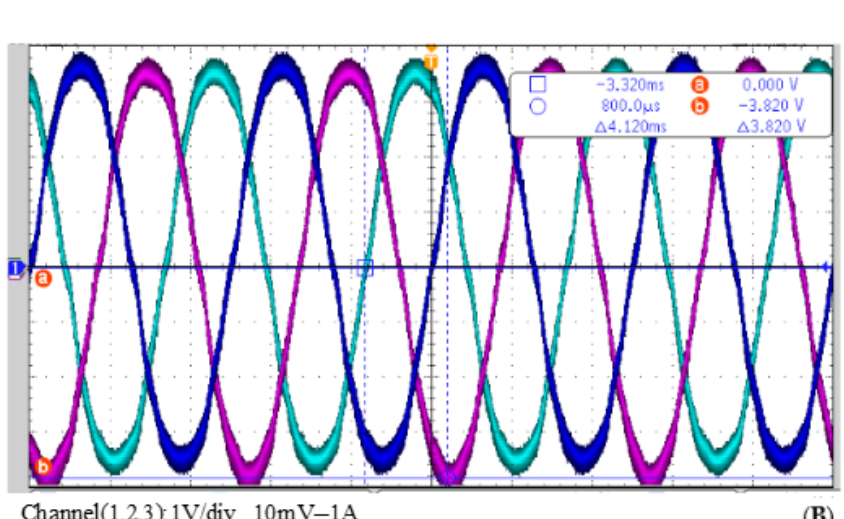
Figure 16. Infrared thermal image. ( a ) T = 119 N·m, n = 4000 rpm, I a = 151 A, ( b ) T = 295 N·m, n = 2000 rpm, I a =351 A.